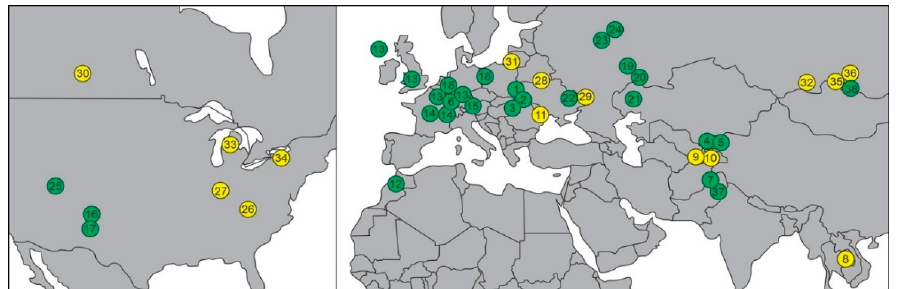
Figure 1. The location of Phanerozoic marine evaporite formations analysed (green colour indicates